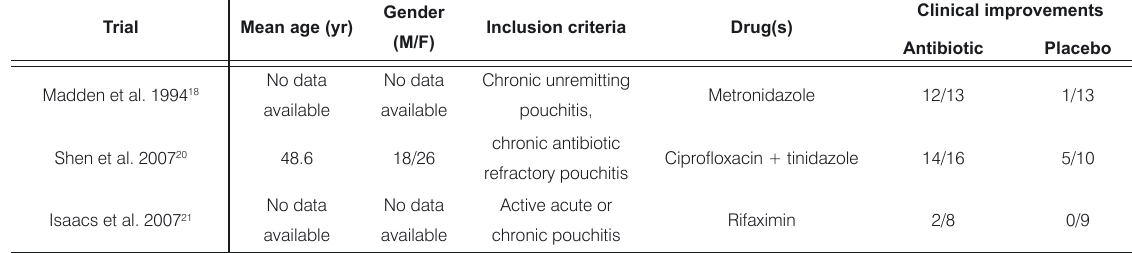
Figure 2. Individual and pooled odds ratios for the outcome of “clinical improvements” in the studies considering antibiotics therapy. Odds ratio meta-analysis plot [fixed effects]